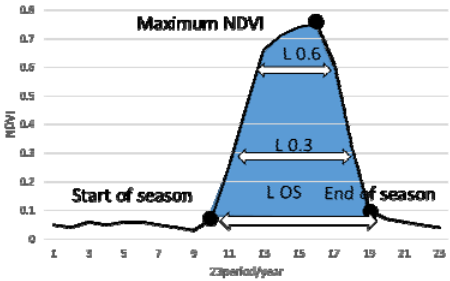
Figure 4. Conceptual image of vegetation phenology Onset approximates the start of the season. Offset is the time fall values of the smoothed NDVI curve have declined to 50% above the right minimum value. Offset approximates the end of the season. LOS is the difference between Onset and Offset.